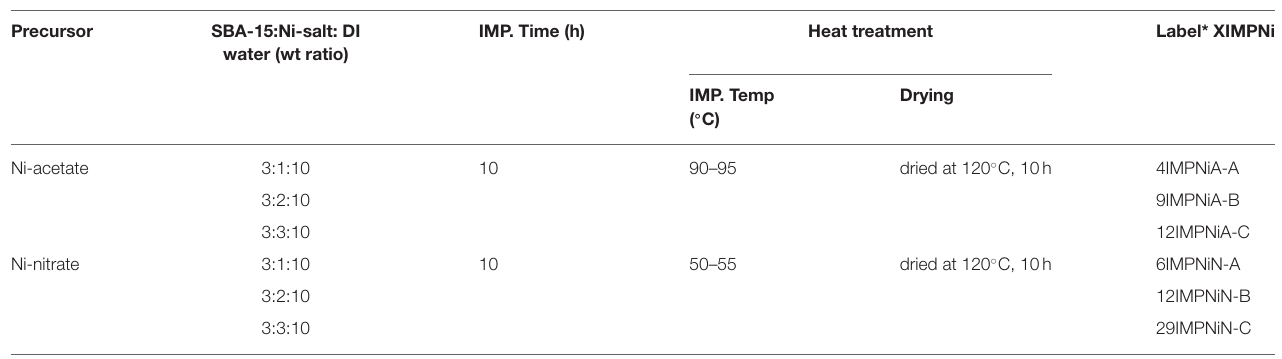
TABLE 1 | Preparation conditions and labels for the monometallic Ni/SBA-15 samples. Precursor SBA-15:Ni-salt: DI water (wt